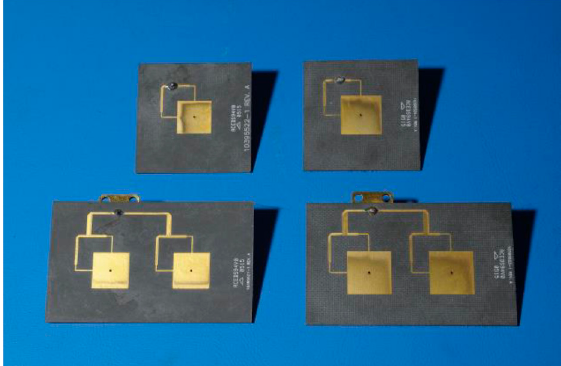
Figure 6. MarCO LGAs and MGAs (Courtesy of N. Chahat).